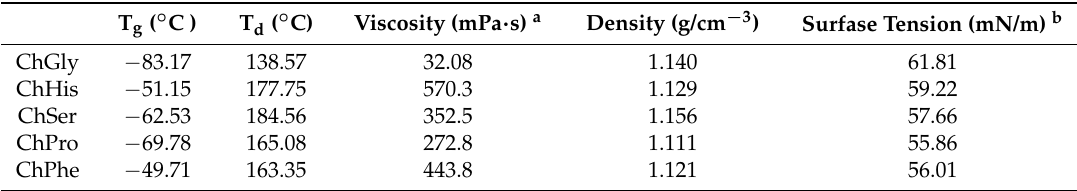
Table 2. Properties of the amino acid ionic liquids (AAILs).